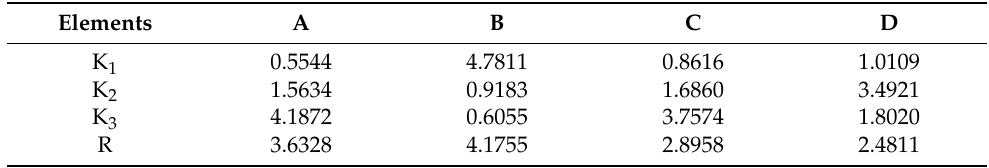
Table 7. Range analysis of tensile strength.